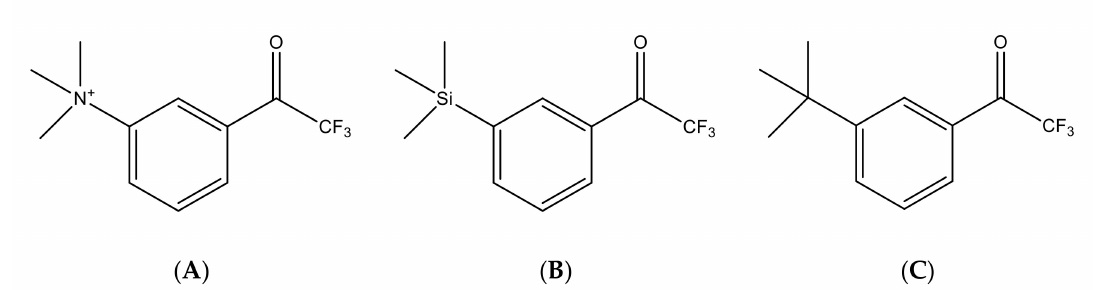
Figure 1. Chemical structure of related trifluoromethylketone molecules: ( A ): 1-[ 3 -(trimethylamino) phenyl]-2,2,2-trifluoro-1-ethanone (TMTFA); ( B ): 2,2,2-trifluoro-1-[ m -(trimethylsilyl)phenyl]-1-ethanone (Zifrosilone); ( C ): 1-(3- tert -butylphenyl)-2,2,2-trifluoroethanone